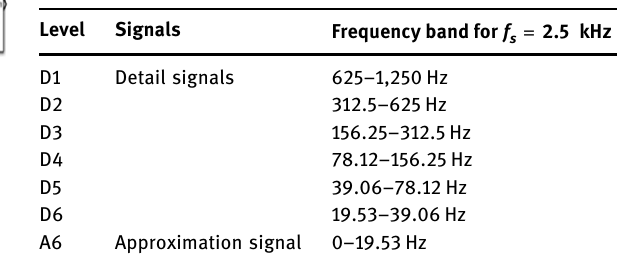
Table 1: Frequency band for wavelet